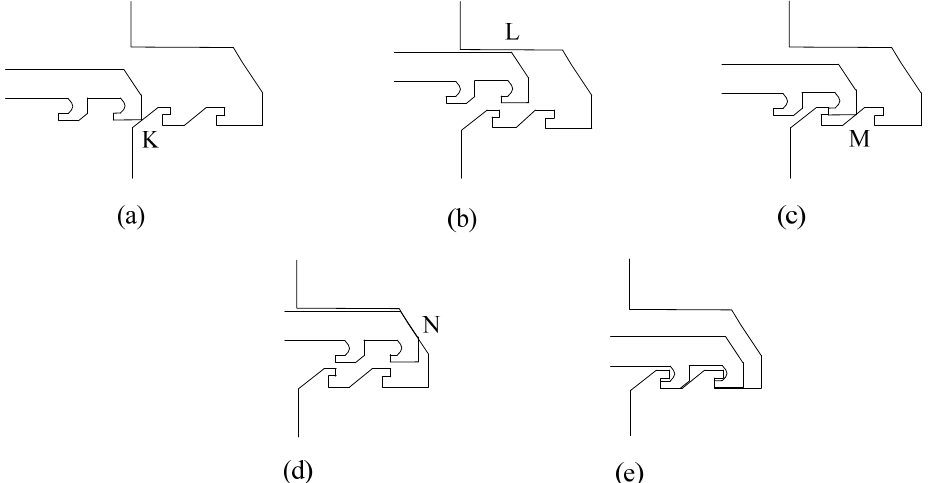
Figure 14. Schematic diagram of locking process. ( a ) Stage 1; ( b ) Stage 2; ( c ) Stage 3; ( d ) Stage 4; ( e ) Stage 5.